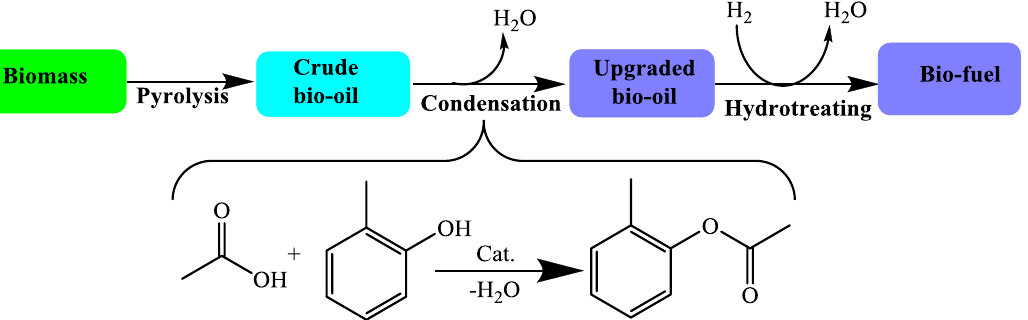
Figure 8. Esterification of acetic acid with o-cresol in bio-oil upgrading [106] .